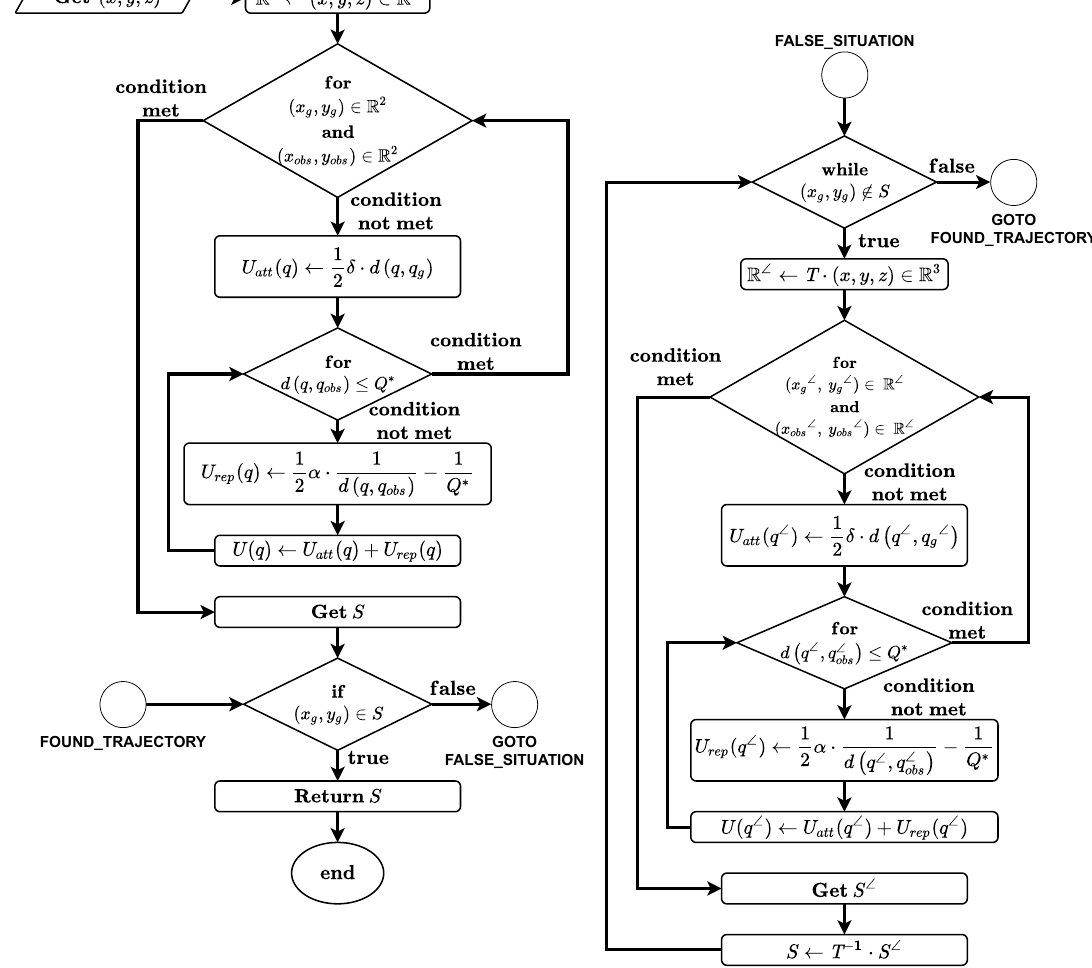
Figure 8. Flowchart algorithm 1: Obtaining feasible